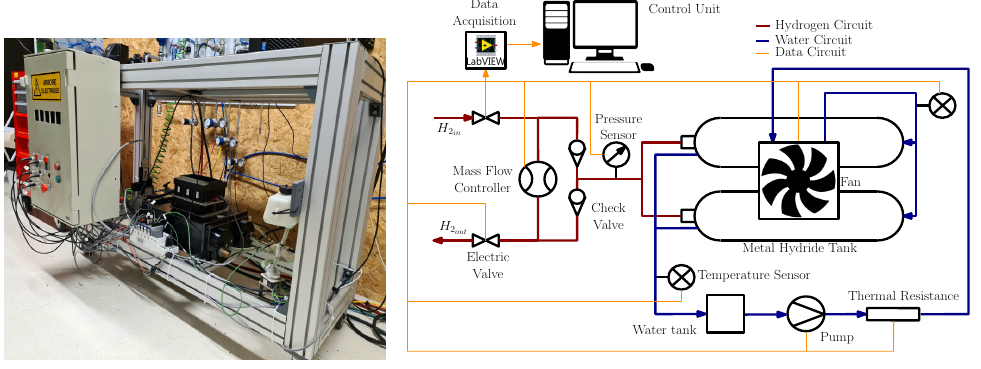
Figure 3. Picture ( left ) and PID ( right ) of the test